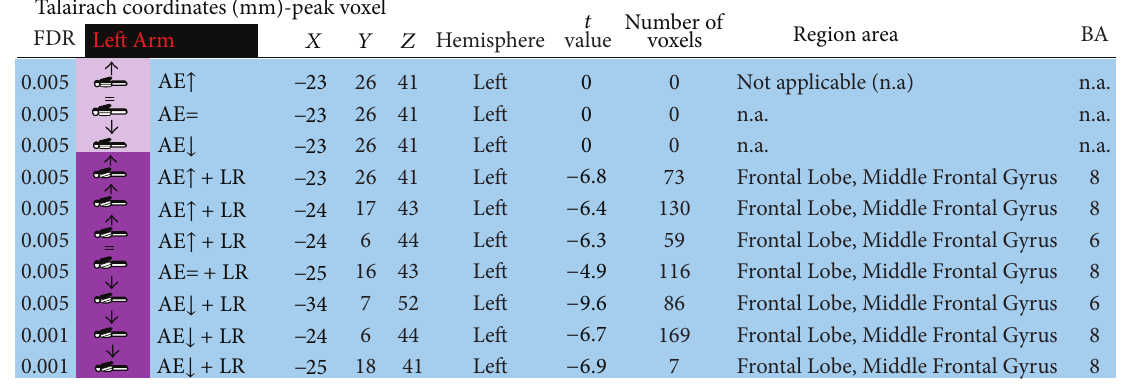
Table 4: Deactivated brain regions by isolated nondominant arm elevation or combined nondominant arm elevation with dominant upper limb restriction.